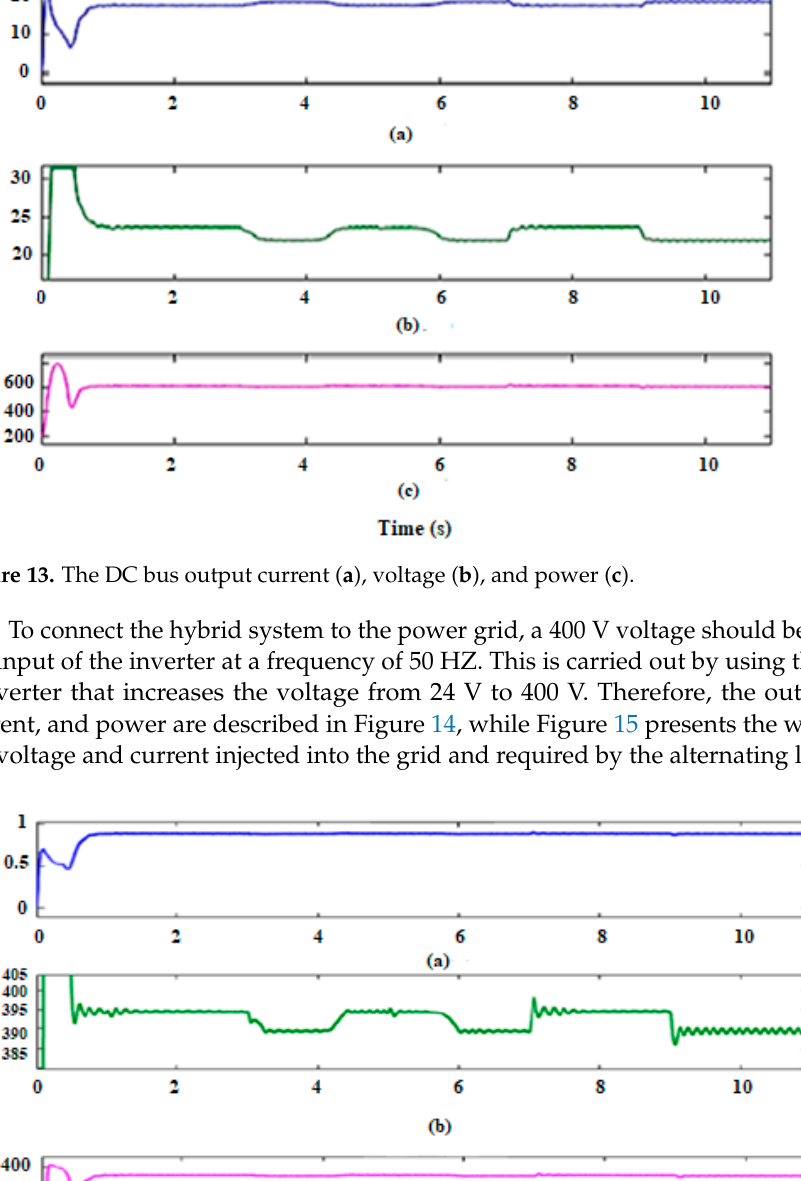
Figure 15. The profile of alternating voltages–currents. The results show that the sum of the absorbed current by the AC load and the current injected into the grid is effectively equal to the current provided by the hybrid power sys- tem. The synchronization of the voltage and current injected to the grid is detailed in Fig- ure 16.